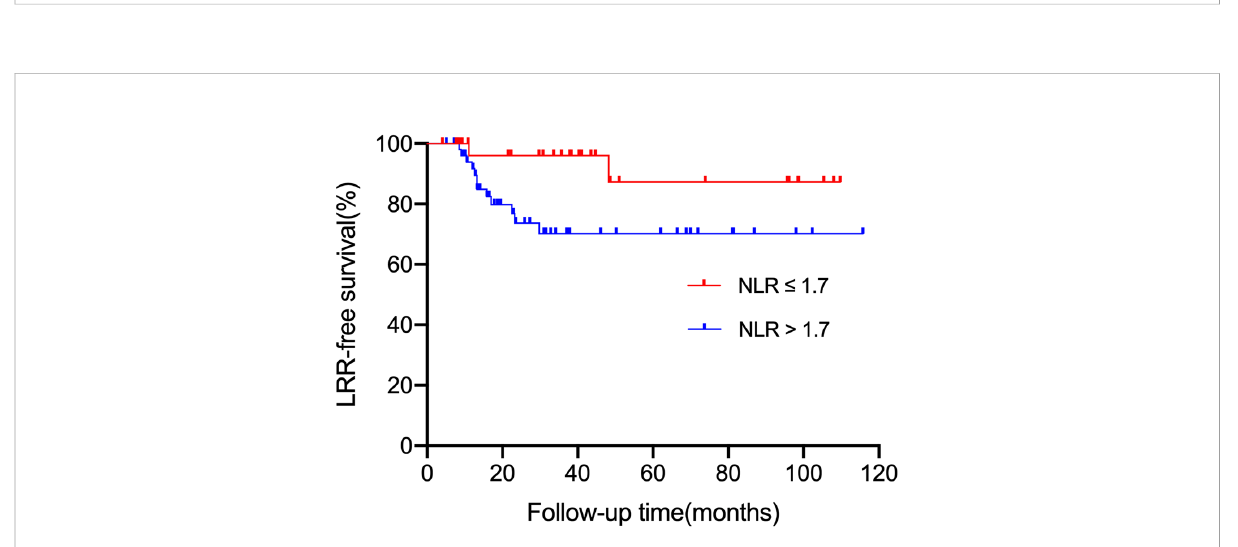
FIGURE 3 LRR-free survival according to NLR status ( ≤ 1.7 vs. > 1.7). LRR , local regional